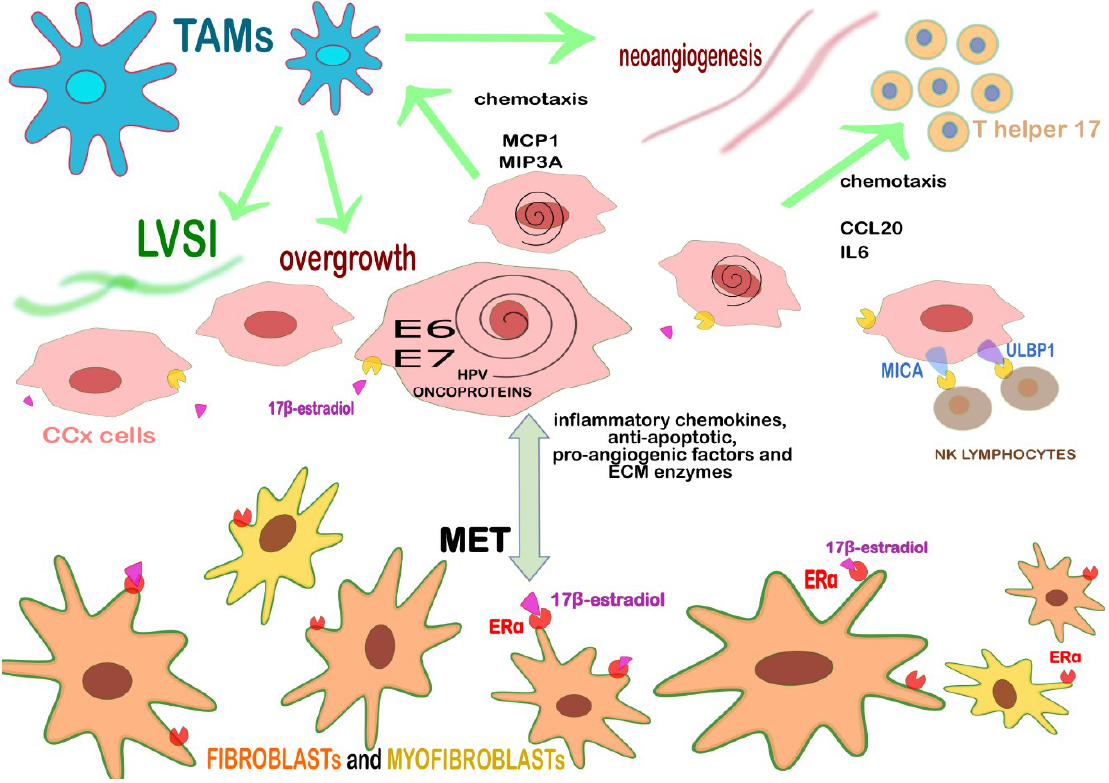
Figure 4. Crosstalk between CCx’s cells and the surrounding stroma. The peritumoral stromal cells in CCx is mainly composed by ERα+ fibroblasts and myofibroblasts, TAMs and TILs. Fibroblasts and myofibroblasts, activated by the binding 17-β-estradiol and its stromal receptor ERα secrete inflammatory chemokines, anti-apoptotic, pro-angiogenic factors and ECM enzymes. They also go through the process of Mesenchymal-epithelial transition (MET). Persistently high-risk HPV+ keratinocytes that became CCx cells exert a chemoattraction for monocytes (MCP1 and MIP3A), Th17 lymphocytes (CCL20, IL6) but also NK cells in advanced stages. The proliferative/pro-angiogenic/pro- inflammatory signature of the TME is sustained by the oncoproteins (E6 and E7) of high-risk HPV but also in concert with the E2 cascade, mostly mediated by the stromal ERα enhanced by the presence of tumor-associated fibroblasts. MICA/B and ULBP1 expressed by CCx cells bind NKG2D, a receptor located on the NK lymphocyte’s surface. Th17 lymphocytes play a role in sustain a chronic pro-